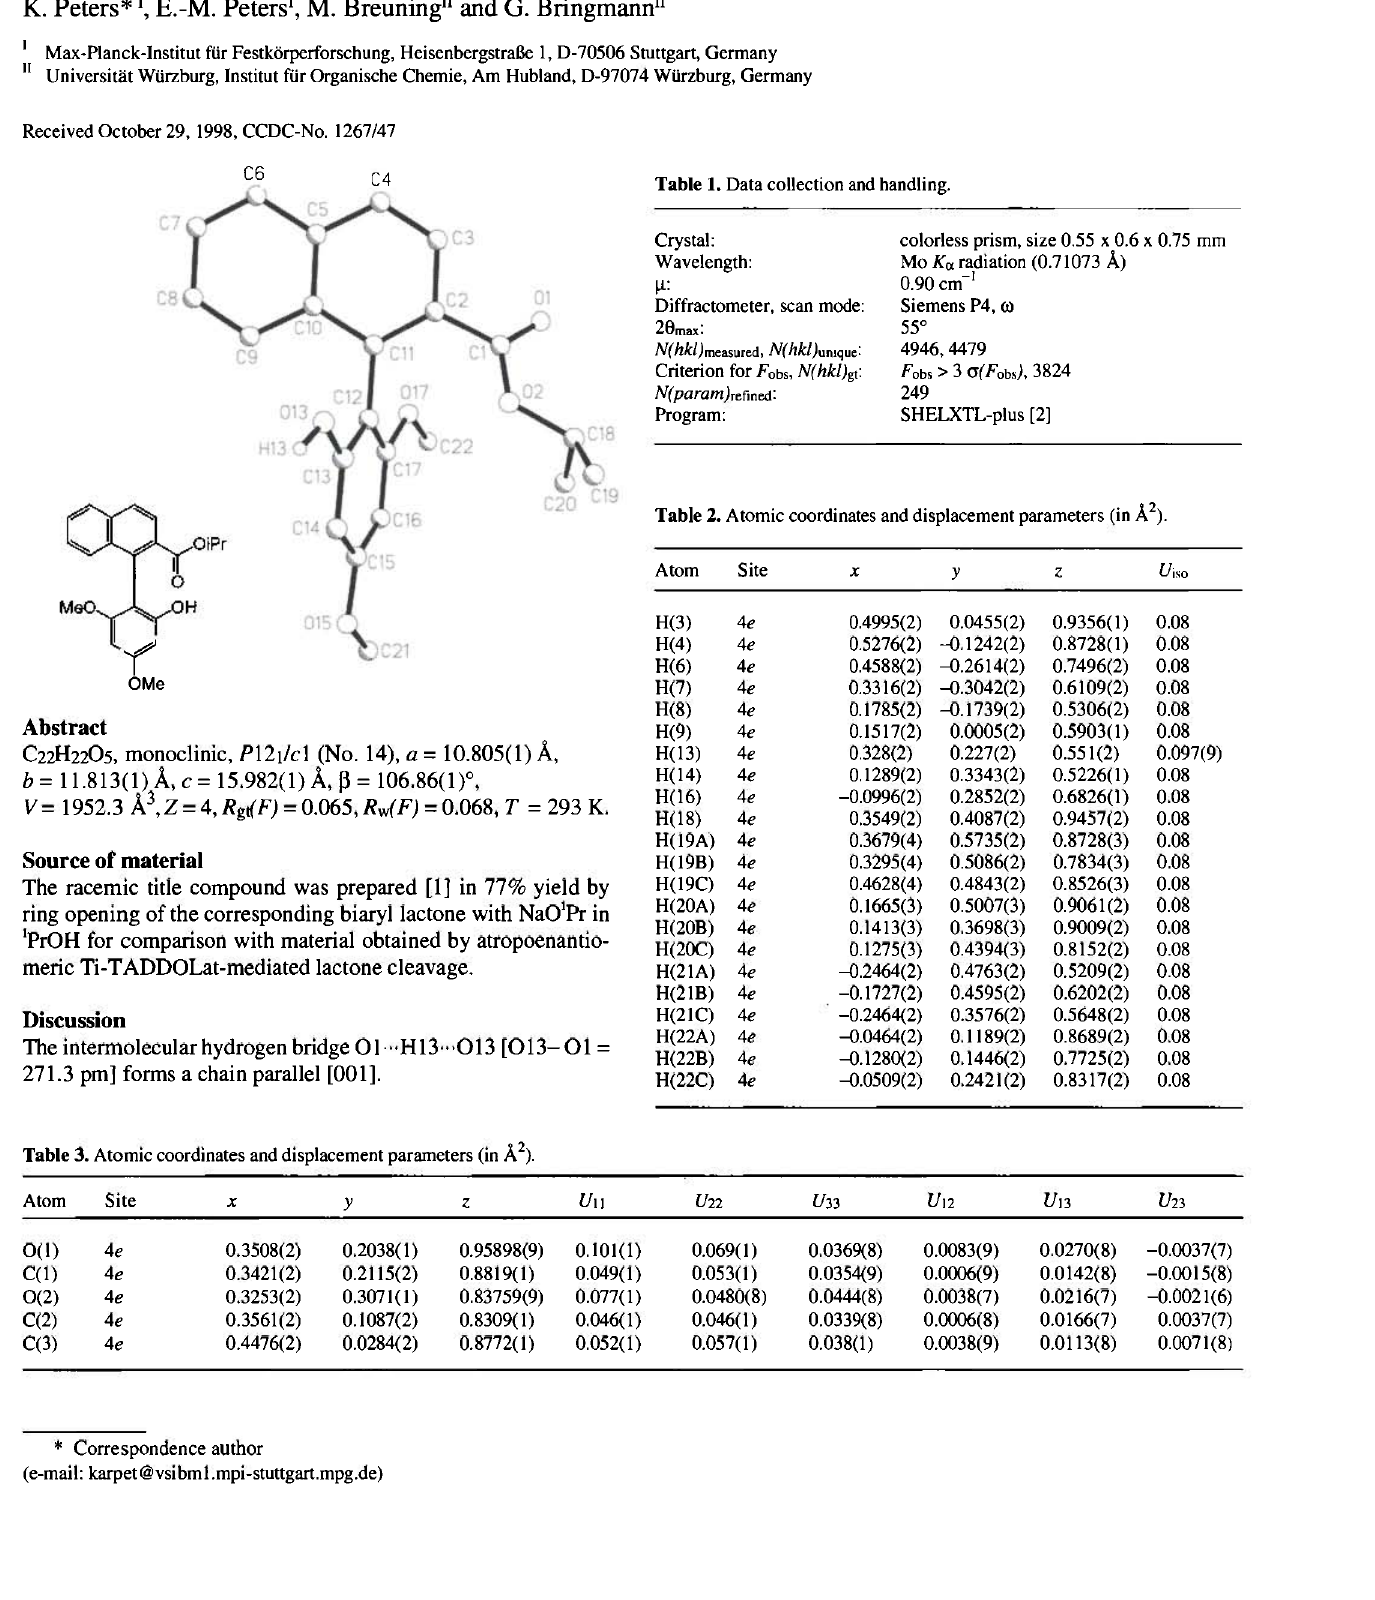
Table 1. Data collection and handling.